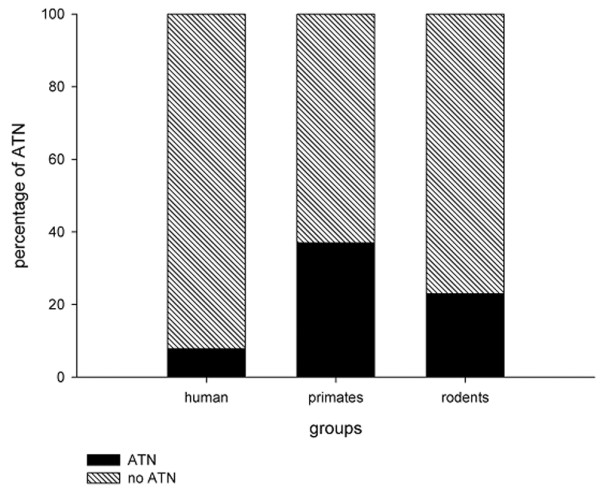
Histogram presenting the percentage of specimens showing ATN from different groups of mammals. Humans appear lest likely to have ATN. ATN, acute tubular necrosis.